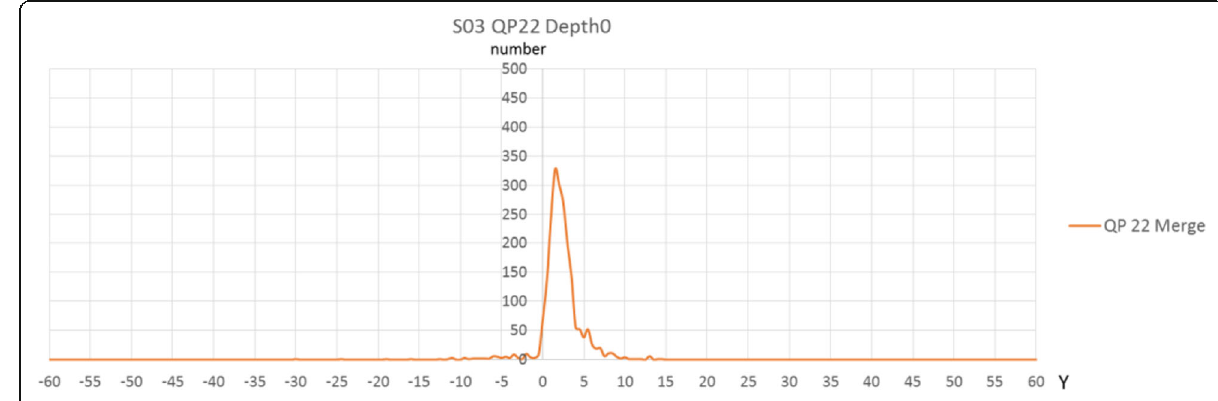
Fig. 10 The distribution of the vertical component for forward prediction ( V Y _ L 0 ) for the S03 sequence